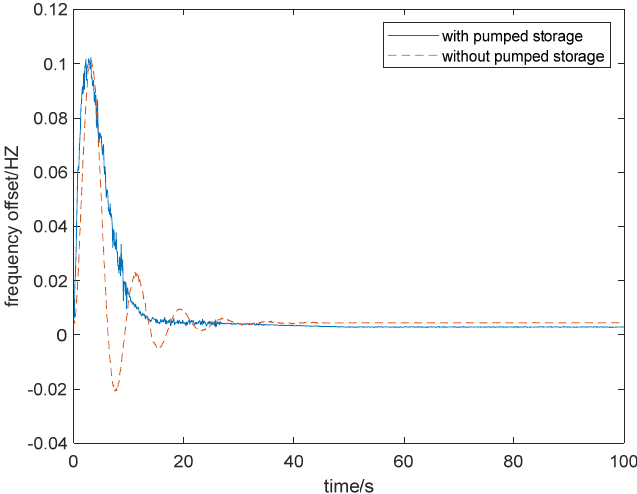
Figure 11. The frequency modulation difference curve of the unit when W = 1.